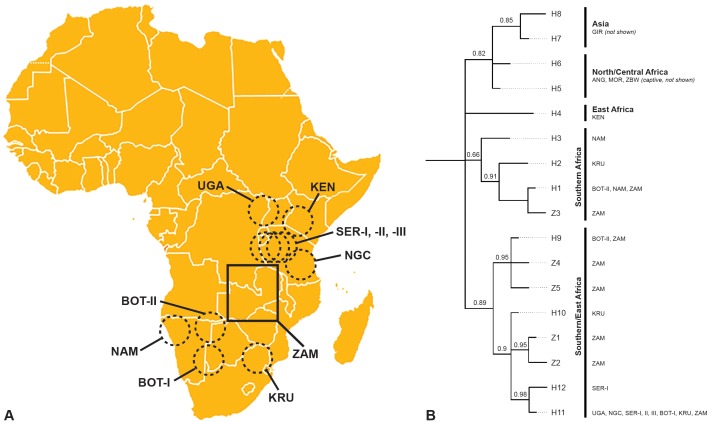
Geographic location of lion samples and phylogenetic relationship of 12S-16S.(A) Range-wide map of lions sampled. Circles indicate geographic locations for populations determined by Antunes et al. [13]. Zambia is denoted by a square. All locations aside from ZAM (Zambia) were established by Antunes et al. [13]: UGA (Uganda); KEN (Kenya); SER (Serengeti National Park, Tanzania); NGC (Ngorongoro Crater, Tanzania); KRU (Kruger National Park, South Africa); BOT-I (Southern Botswana and Kalahari, South Africa); BOT-II (Northern Botswana); NAM (Namibia); GIR (Gir Forest, India); ANG (Angola); ZBW (Zimbabwe); and MOR (Morocco). (B) Bayesian analysis with posterior probability values on the nodes. H1-H12 are haplotypes that were described by Antunes et al. [13] and Z1-Z5 are novel haplotypes so far only found within Zambia.